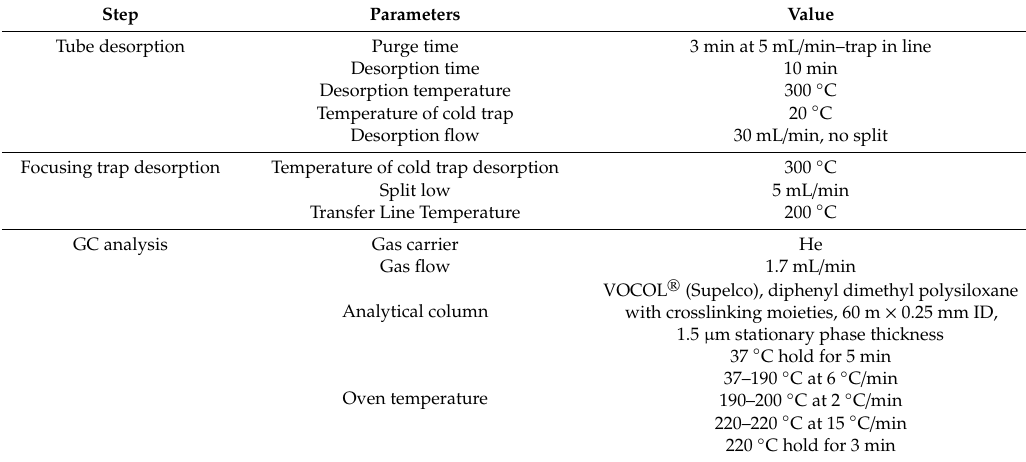
Table 2. Operative condition of TD-GC / MS